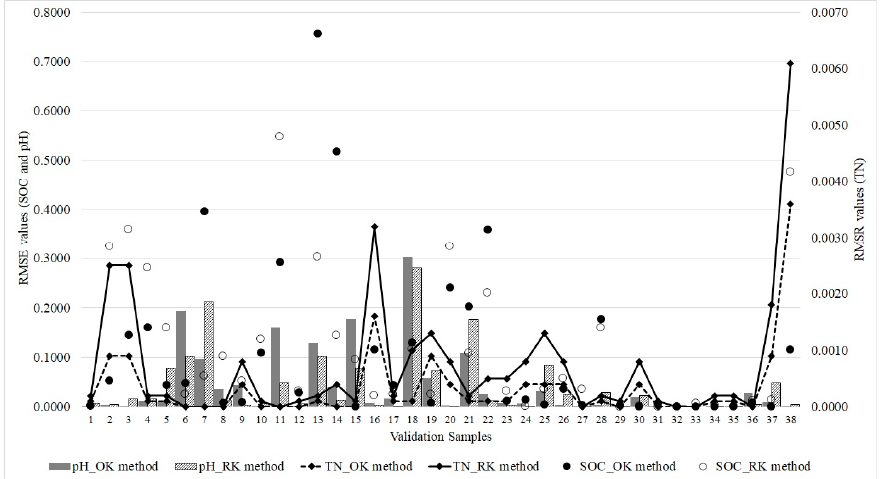
Figure 7. Root mean square error (RMSE) values of validation samples.